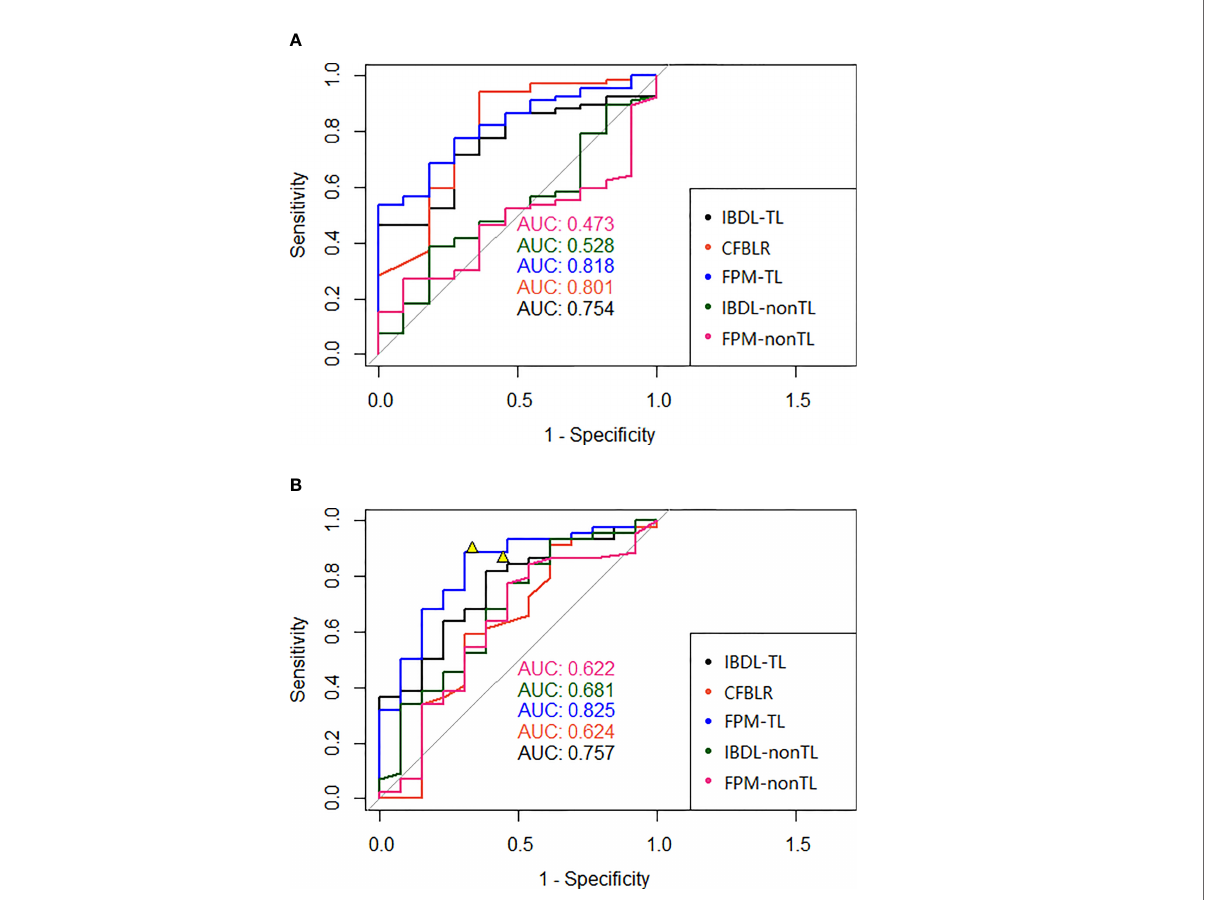
FIGURE 3 | (A) The ROC of each model (clinical model, two image feature models with or without transfer learning, and two fusion models with or without transfer learning) in the test data set of our hospital was presented in (A) ; (B) The ROC of each model (clinical model, two image feature models with or without transfer learning, and two fusion models with or without transfer learning) of the independent test data set in the external hospital was presented in (B) . The fi gures also showed two representative points of the interpretation doctors. AUC, Area under the ROC curve; IBDL-TL, Image-based Deep Learning (transfer learning) model; CFBLR, clinical feature based regression; FPM-TL, fusion prediction model (transfer learning); IBDL-nonTL, Image-based Deep Learning (non-transfer learning) model; FPM-nonTL, fusion prediction model (non-transfer